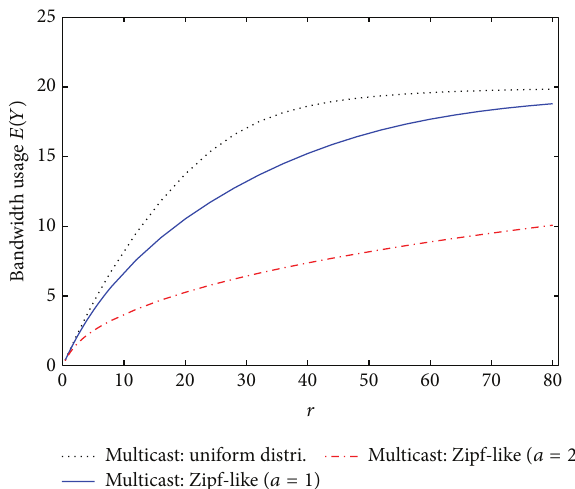
Figure 9: Bandwidth usages of unicast and multicast IPTV services under the scenario of heterogeneous service rates. (Hit rate distri- bution: